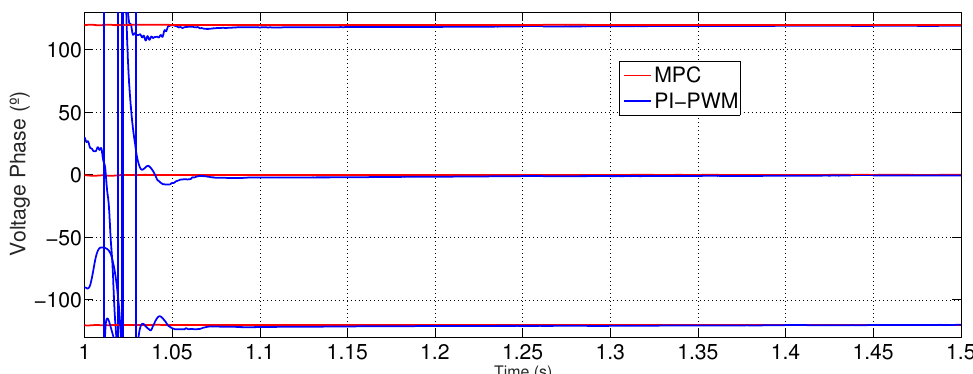
Figure 5. Voltage Magnitude for phase A at the PCC.